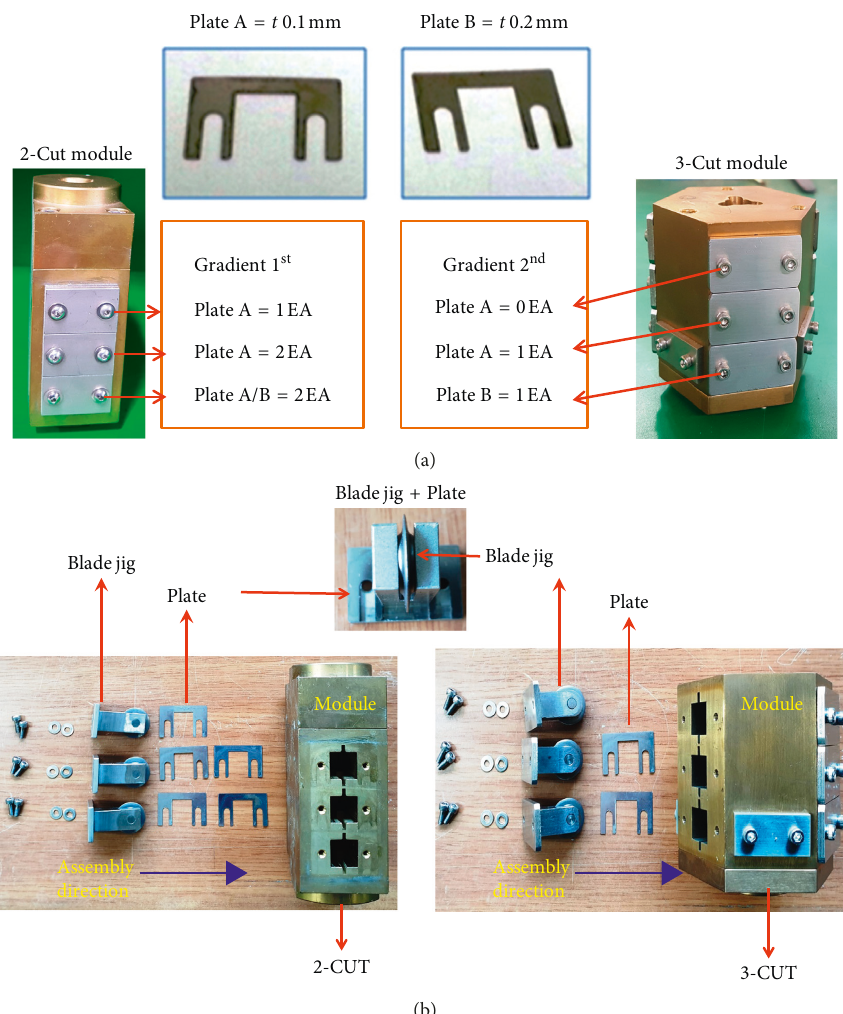
Figure 6: Gradient variable of modules using the plate: (a) assembly of module; (b) disassembly of module.